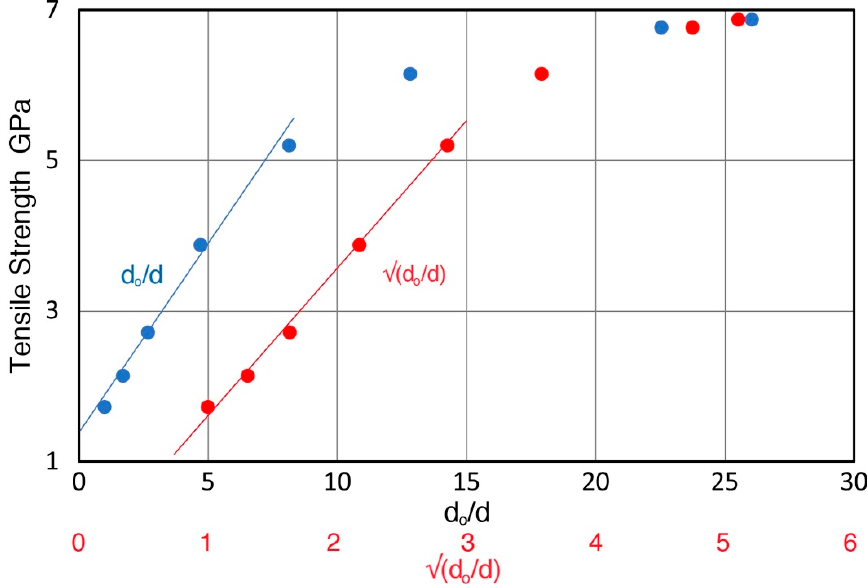
Figure 5. Tensile strength versus length parameters. Fits improve substantially without high strain data points. Li data [3].